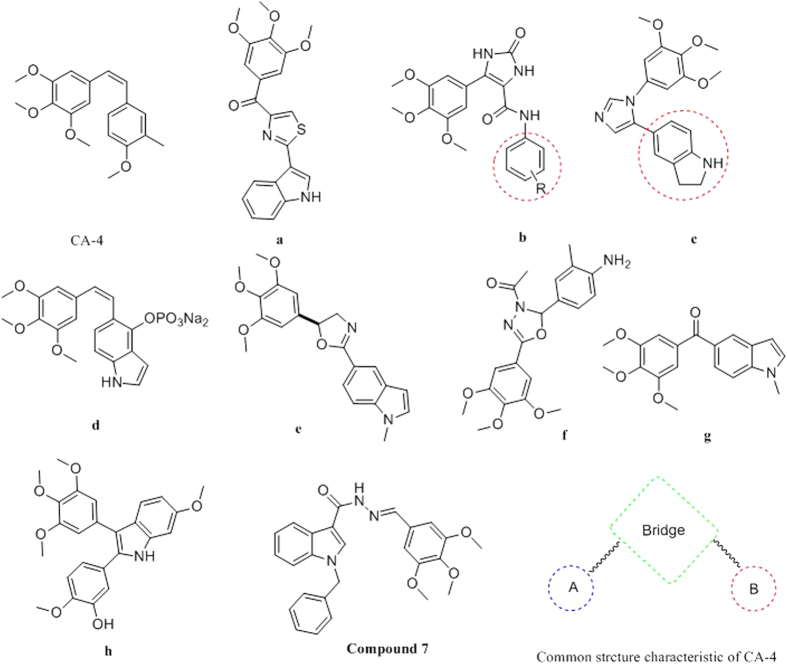
The chemical structure of CA-4 and its analogues.